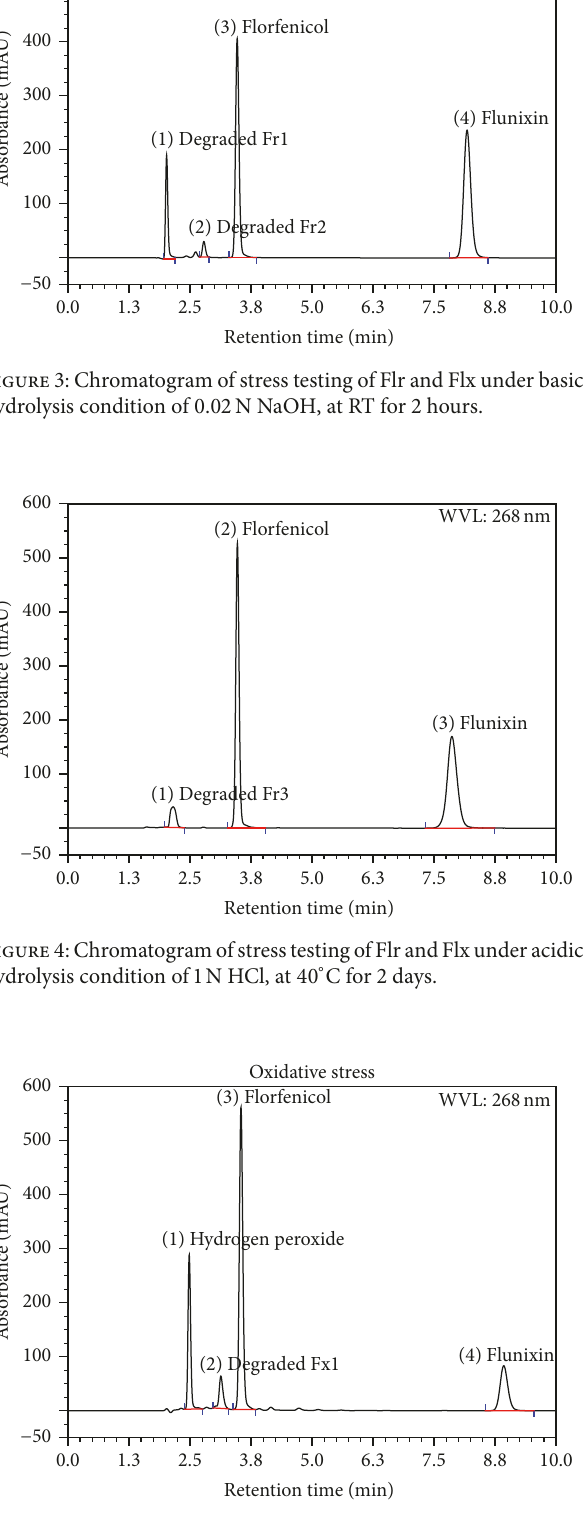
Figure 5: Chromatogram of stress testing of Flr and Flx under oxidative condition of 0.2% H 2 O 2 at 40 ∘ C, protected from light for 7 days.